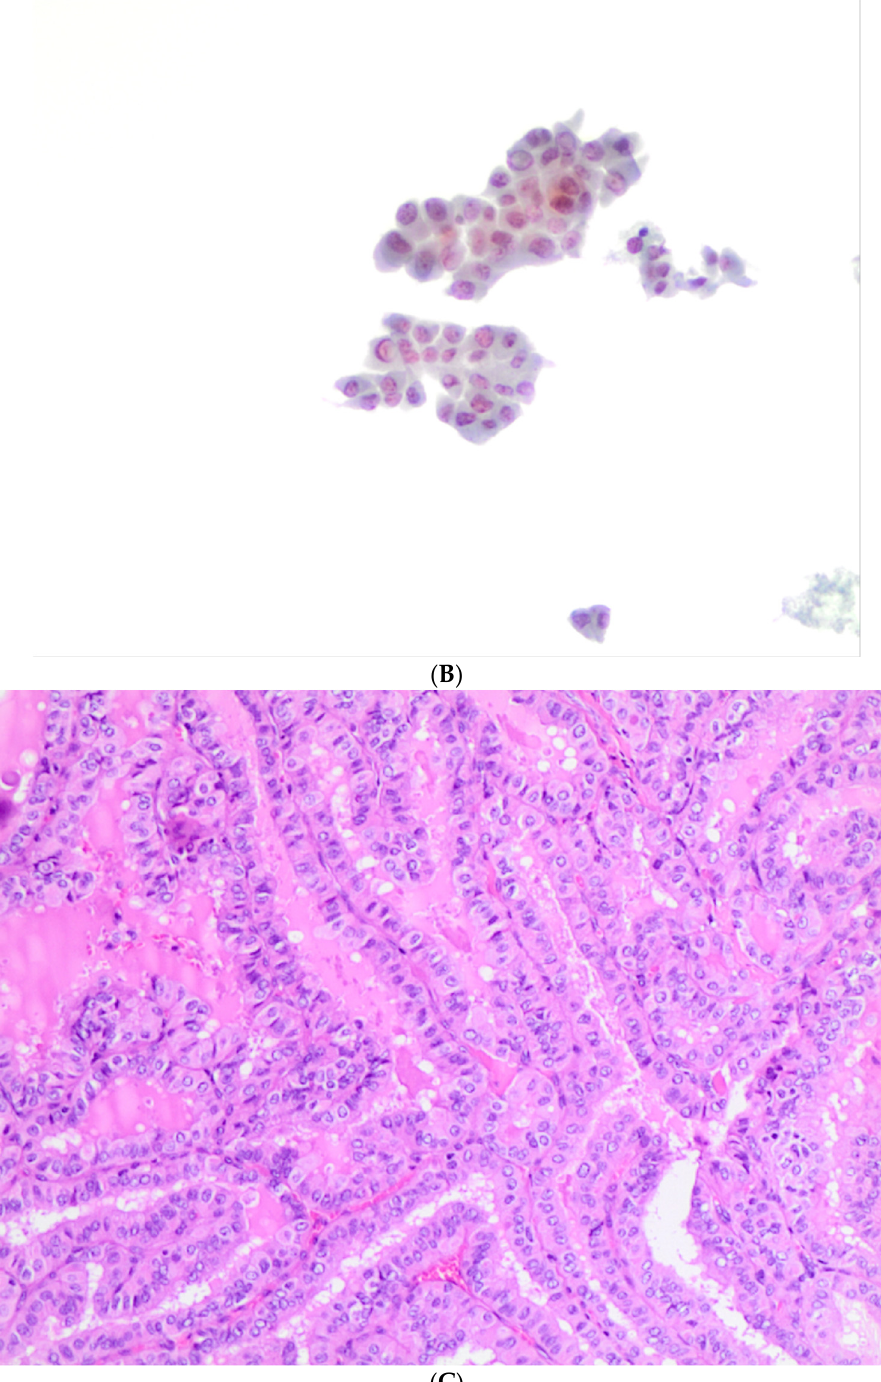
Figure 2. ( A , B ) The pictures show the morphological features diagnosed as positive for malignancy, favoring a papillary thyroid carcinoma (PTC) characterized by atypical and pleomorphic nuclei, some grooves, and nuclear pseudoinclusions (400× liquid-based cytology (LBC)). ( C ) The picture shows the histological features from the same case diagnosed as PTC with tall cell features (200×,